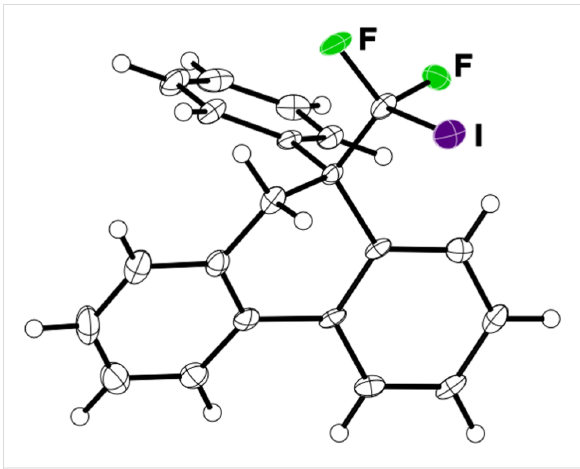
Figure 1: ORTEP diagram of 2a with 50% ellipsoid probability.